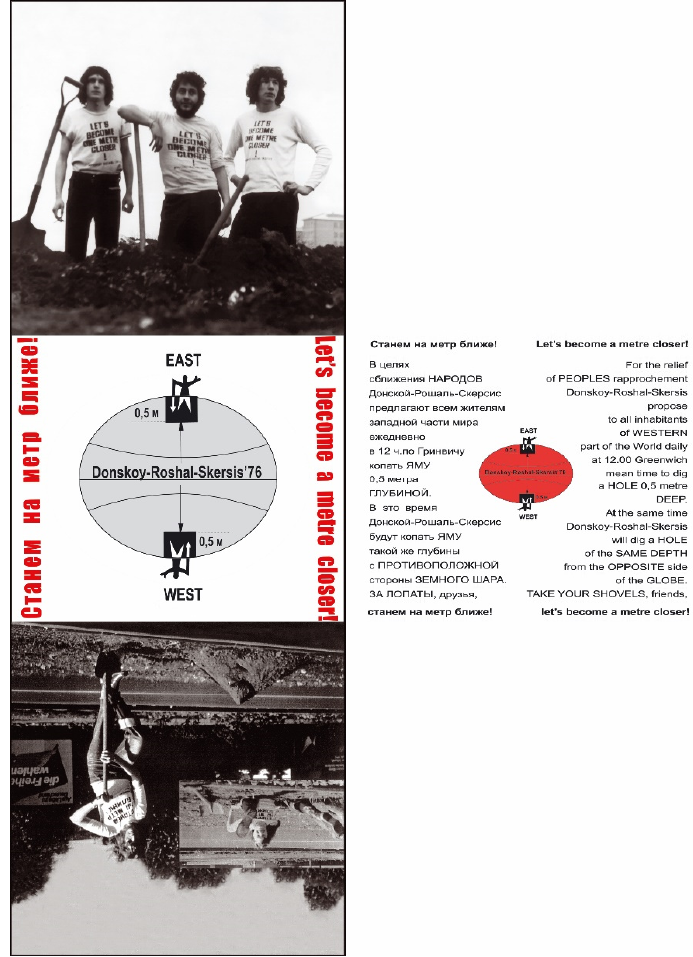
Figure 6. The Nest. Let’s Become 1 Meter Closer! 1977. Photographs, paper. Documentation of action. Courtesy of the artist.